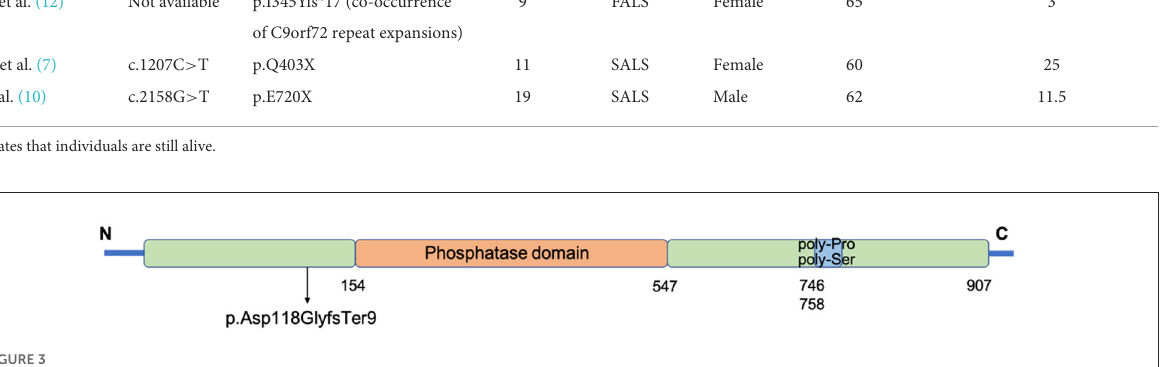
FIGURE3 Schematic graph of the FIG4